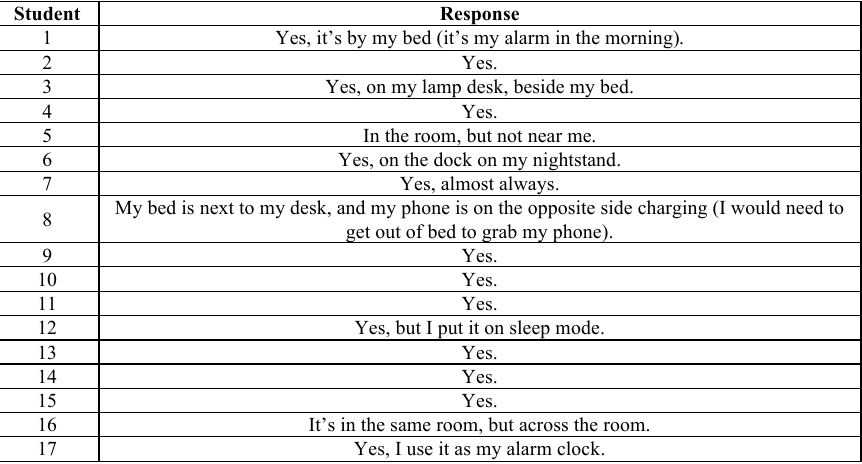
Table 6. Question 6: Is your smart phone near you when you sleep?